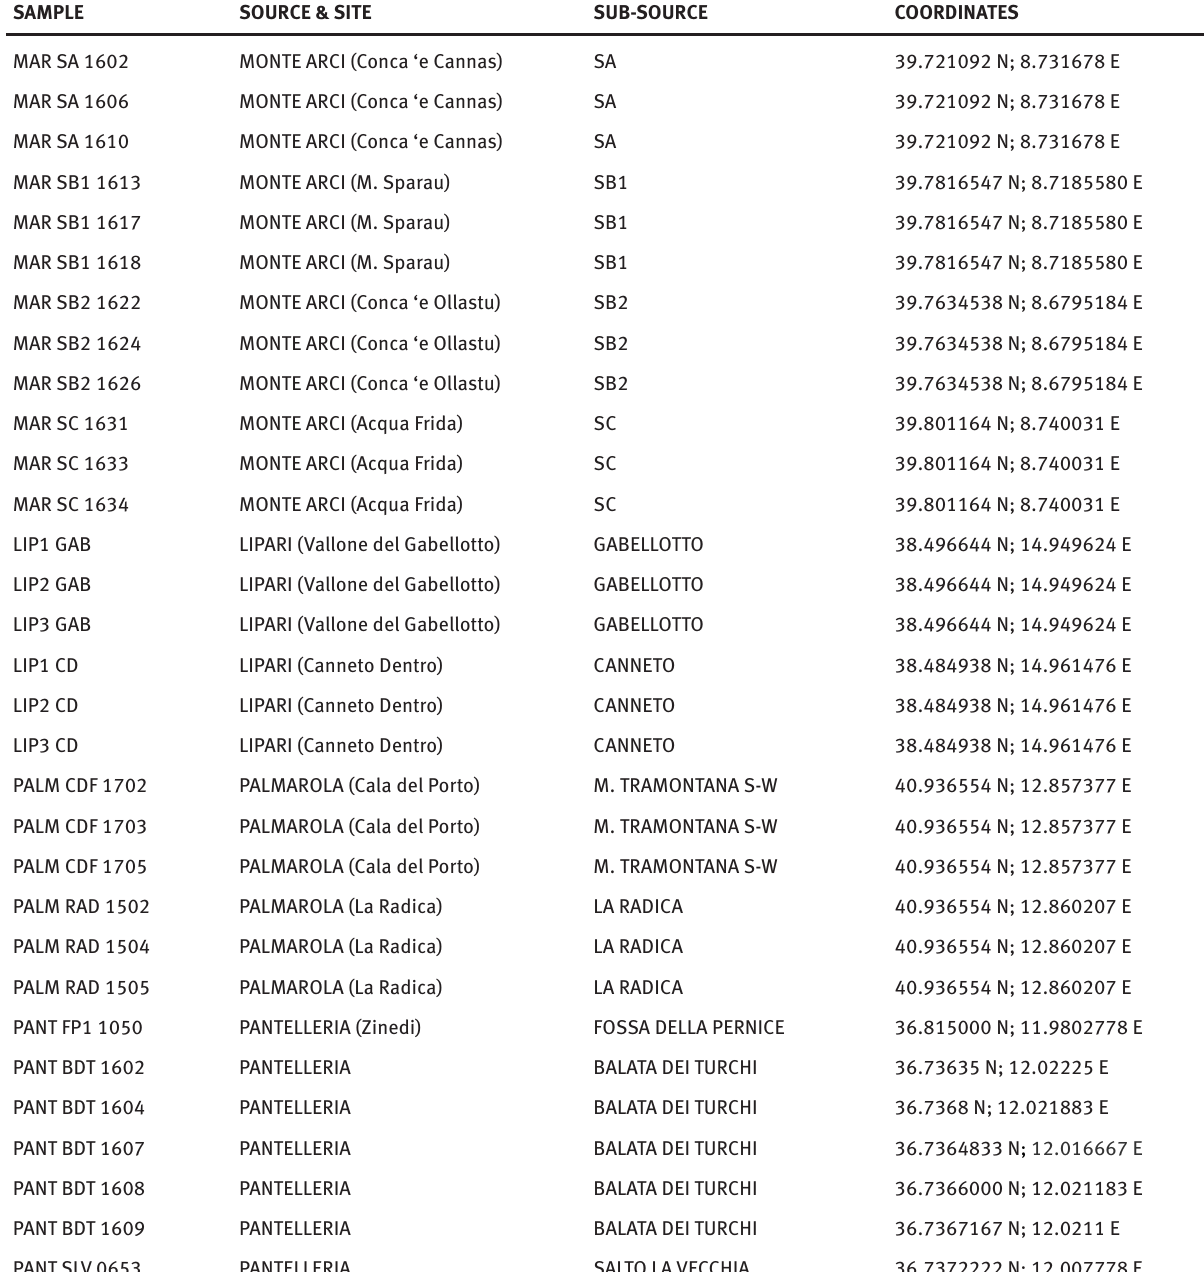
Table 2: Geological sample location. For each one, collecting place, source, sub-source, and coordinates are specified. Sample abbreviation: MAR = Monte Arci; LIP = Lipari; PALM = Palmarola; PANT = Pantelleria.